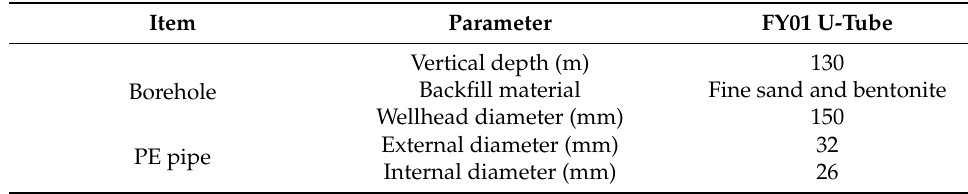
Table 1. Borehole and U-Tube parameters.